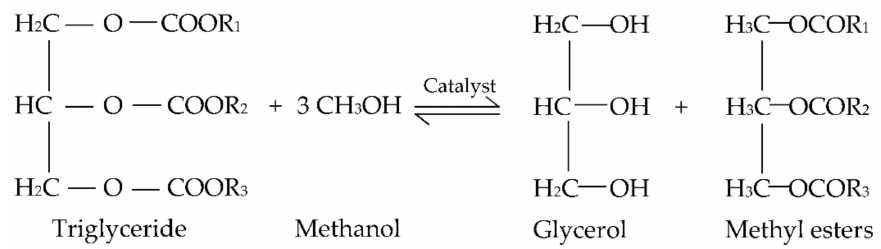
Figure 1. A schematic representation of the transesterification reaction.